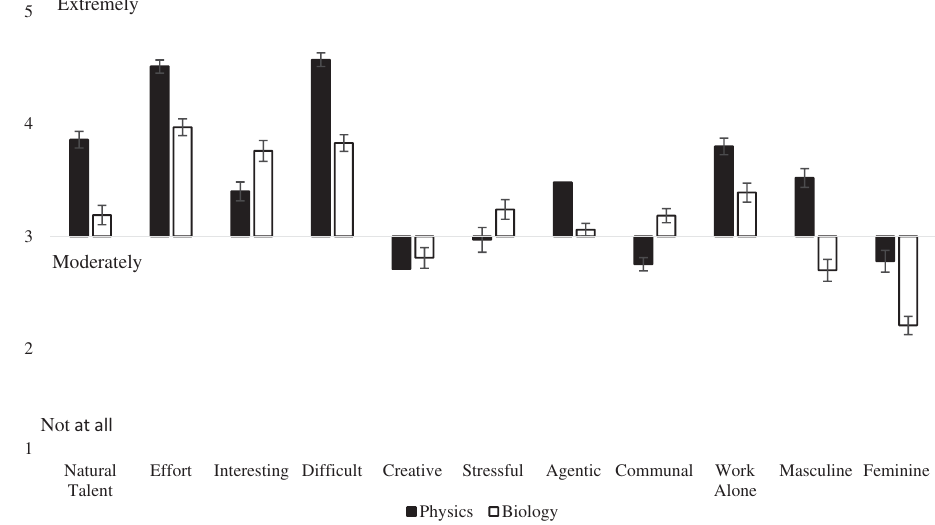
FIG. 2. Bar graph of field characteristic stereotypes. The error bars represent standard error. See Table III for sample sizes.